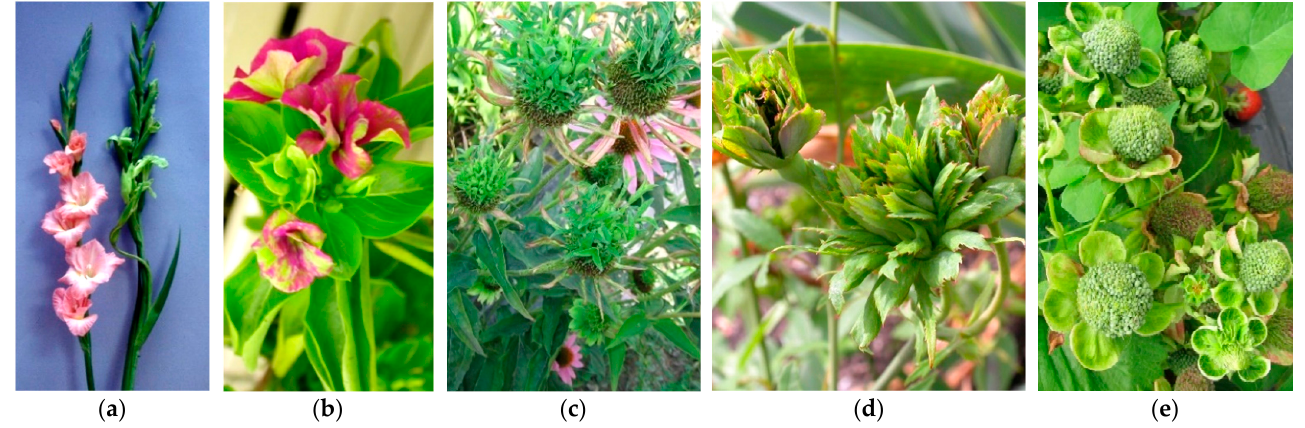
Figure 5. Virescence in gladiolus ( a ) and in periwinkle ( b ); phyllody in echinaea ( c ), rose ( d ), and strawberry ( e ). The rose flowers are showing virescence and phyllody due to genetics, rather than the phytoplasma presence in all the others.